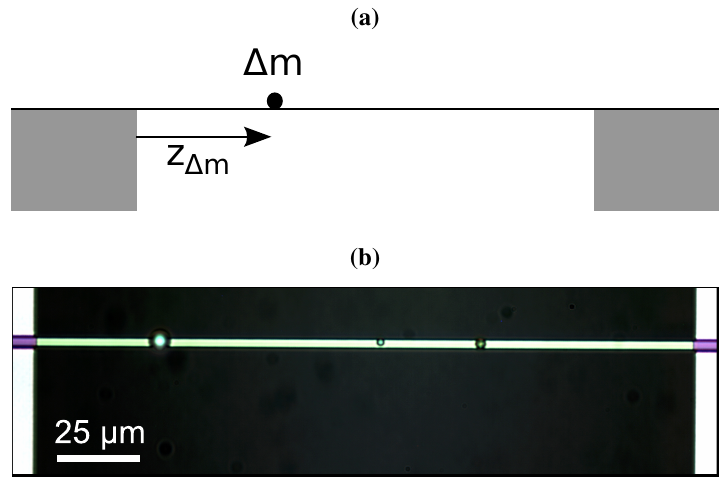
Figure 1. (a) Schematic side view of a string with a single particle of mass ∆ m positioned at z . (b) Microscope top view of a silicon nitride string with 3 different particles attached. ∆ m From left to right: 6 µm Polybead, 2 µm Polybead, and 2.8 µm